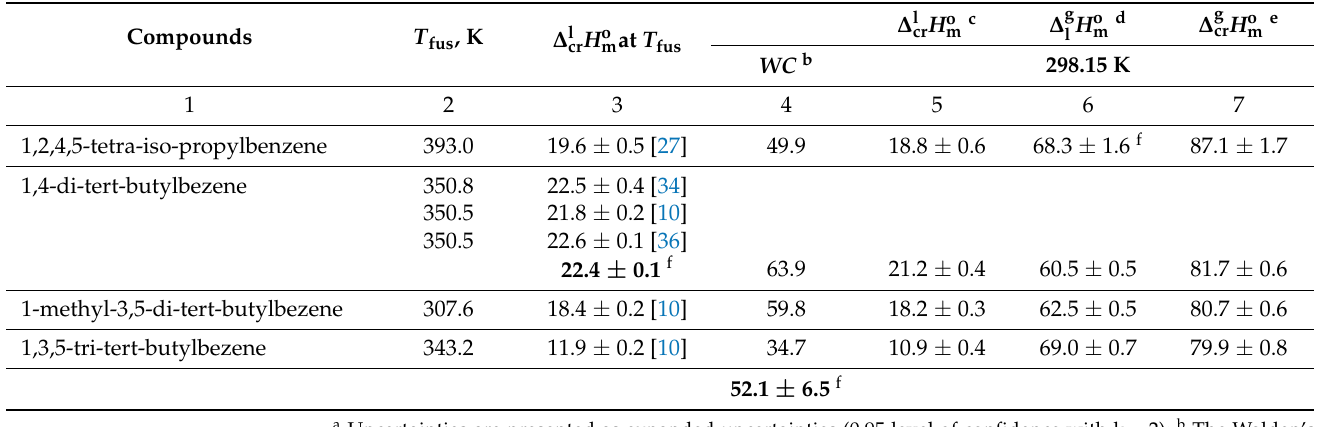
Table 4. Phase transition thermodynamics of alkylbenzenes (in kJ · mol − 1 ) a . Compounds T fus ,